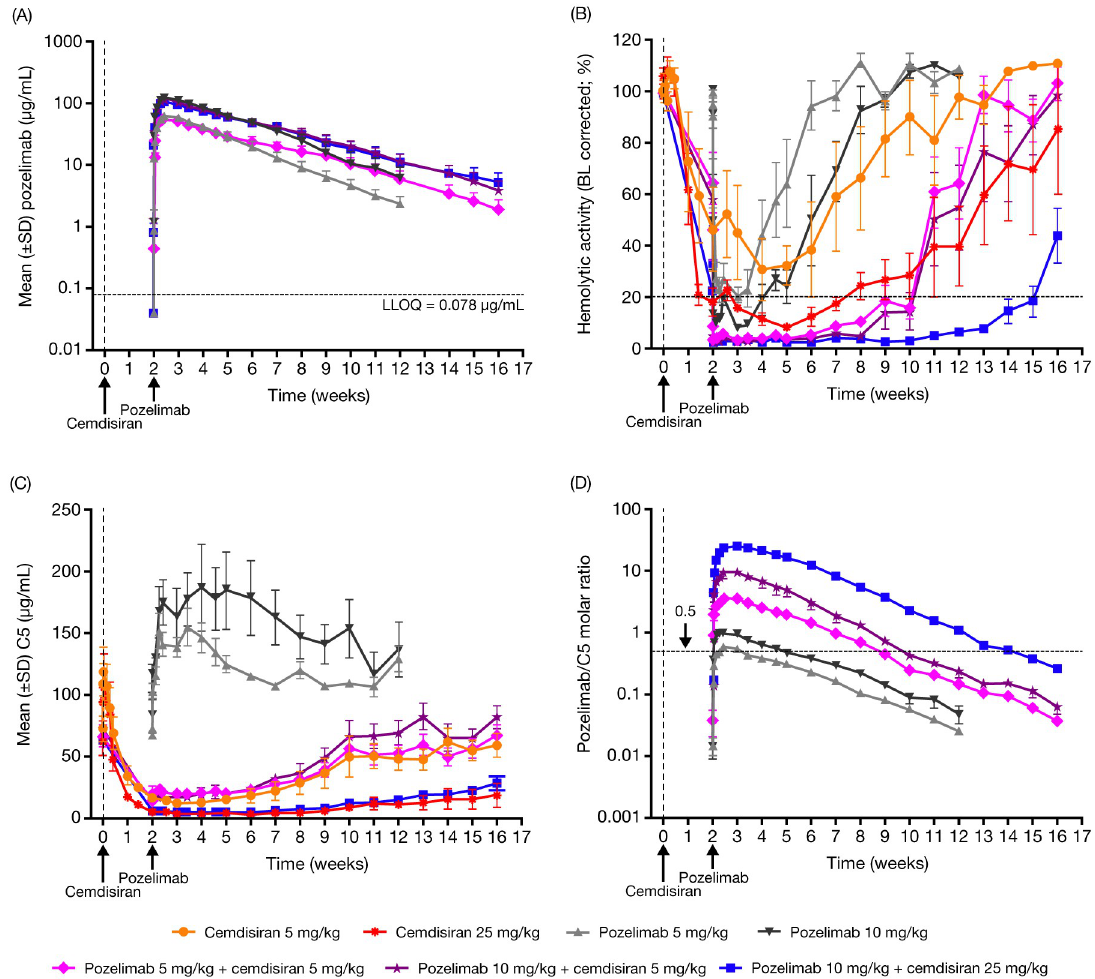
Fig 1. (A) Mean total concentrations of pozelimab in serum after single subcutaneous injection of pozelimab alone or in combination with cemdisiran in male cynomolgus monkeys; � (B) [baseline corrected] ex vivo classic pathway hemolysis in serum from cynomolgus monkeys administered pozelimab alone or in combination with cemdisiran; (C) total mean C5 concentrations in serum from cynomolgus monkeys administered pozelimab alone or in combination with cemdisiran; and (D) pozelimab/C5 molar ratios in serum over time. BL, baseline; C5, complement component 5; LLOQ, lower limit of quantitation; SD, standard deviation. � Total pozelimab concentrations below the LLOQ ( < 0.078 μ g/mL) were imputed as LLOQ/2 (0.039 μ g/mL), and concentration values considered by the investigator to be outliers were excluded for all animals from Groups 5–7 at Day 78. Concentration values considered by the study investigator to be impacted by anti-drug antibodies were excluded; excluded values were from one animal in the pozelimab 10 mg/kg